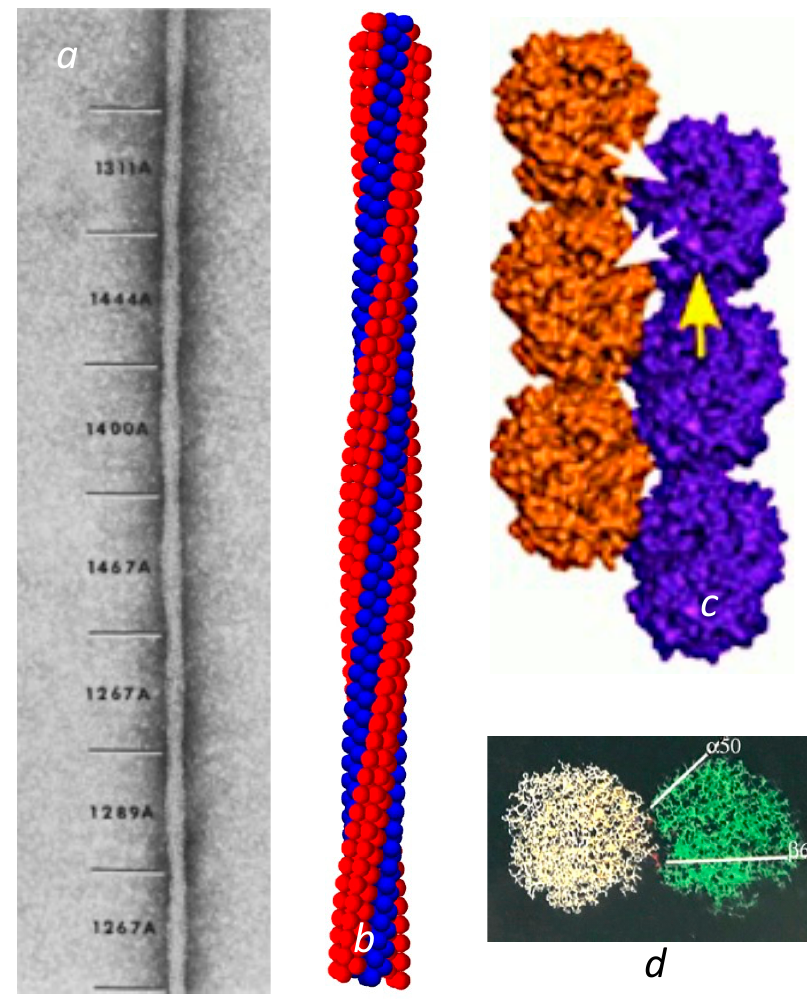
Figure 1. Fiber and double strands. ( a ) Electron micrograph of a negatively stained sickle fiber. Reprinted with permission from [7] 1988, Journal of Structural Biology. The undulating width is the consequence of the rotating elliptical cross section. The varying pitch is designated by the numbers shown in angstroms. ( b ) Reconstructed model of the fiber. The model is primarily based on Carragher et al. [8]. However, this is also the first demonstration that the meshing of four strands into a quad- strand [9] is fully compatible with a long 14-stranded fiber. ( c ) The crystal double strand [3]. Note that there are lateral contacts, shown with white arrows, where the mutation site is, as well as axial contacts as illustrated by the single yellow arrow. (For a detailed visualization of the location of all the amino acids in the contact region, the reader is referred to the figures in [3]). ( d ) The lateral interface viewed from the top (as down the axis of ( c )). Not only does the β 6 Val form a contact, but a distance away, α 50 His also makes a contact that is markedly sensitive to